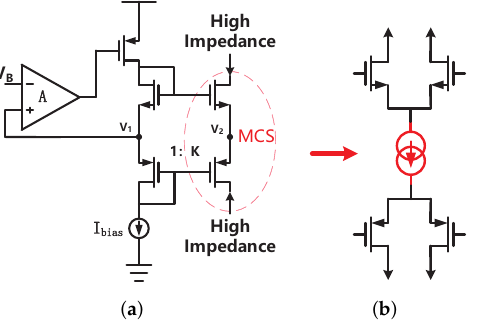
Figure 6. ( a ) Schematic of mid-rail current sink/source (MCS). ( b ) Connection of differential pairs.